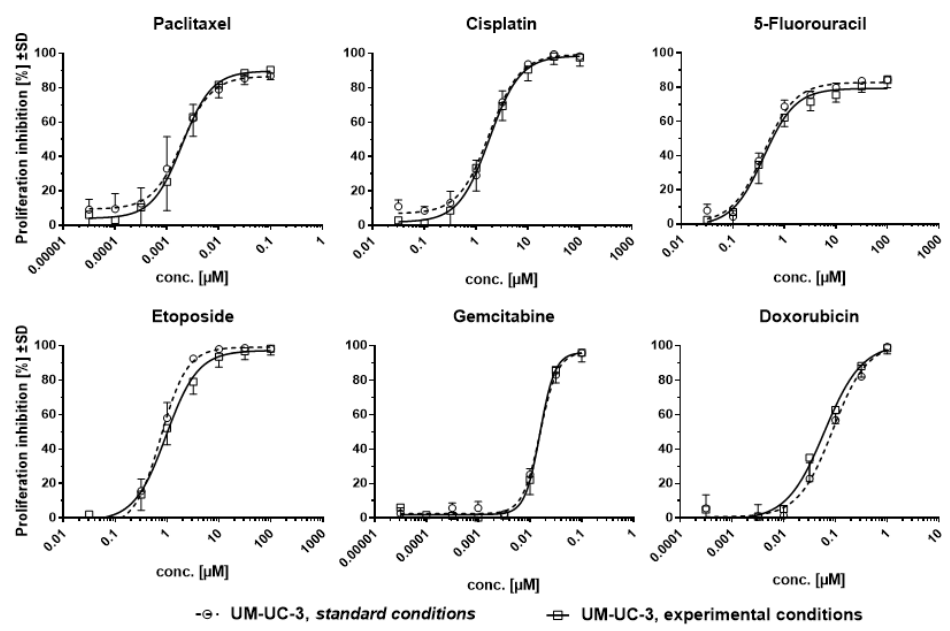
Figure 13. Dose–response curves obtained for UM-UC-3 cells cultured in standard or experimental conditions for 72 h with selected drugs. Curve fitting was carried out using [Inhibitor] vs. response- Variable slope (four parameters) nonlinear model in GraphPad Prism 7.0 software.